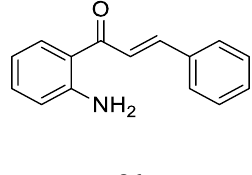
Figure 21. Chemical structure of 2-aminochalcone.